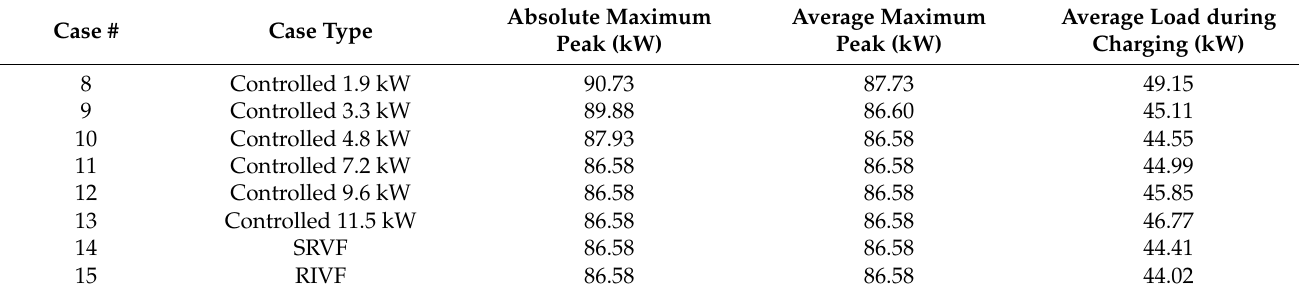
Table 5. Demand from each controlled